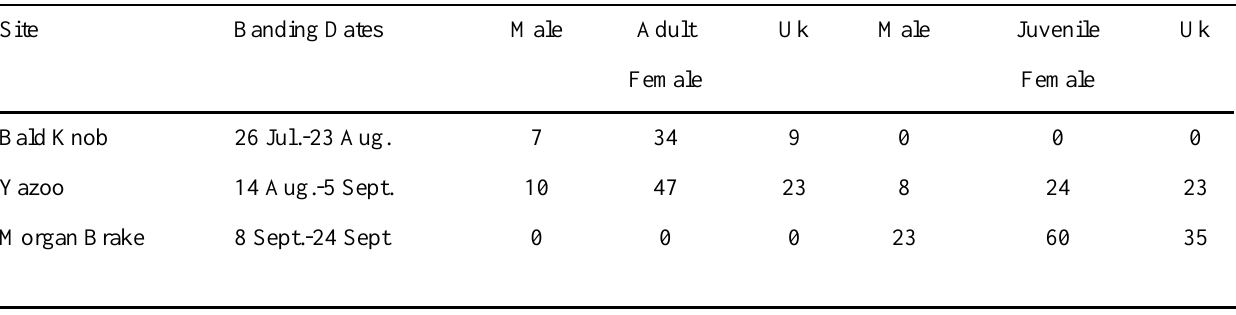
Table 1. Least Sandpipers captured by sex and age at Bald Knob National Wildlife Refuge (Bald Knob) in Arkansas, and Yazoo National Wildlife Refuge (Yazoo), and Morgan Brake National Wildlife Refuge (Morgan Brake) in Mississippi during July-September 2002.